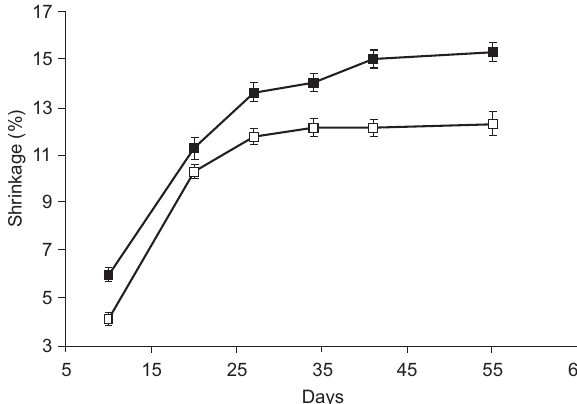
Figure 1. Shrinkage percentage in weight for A. brasiliensis